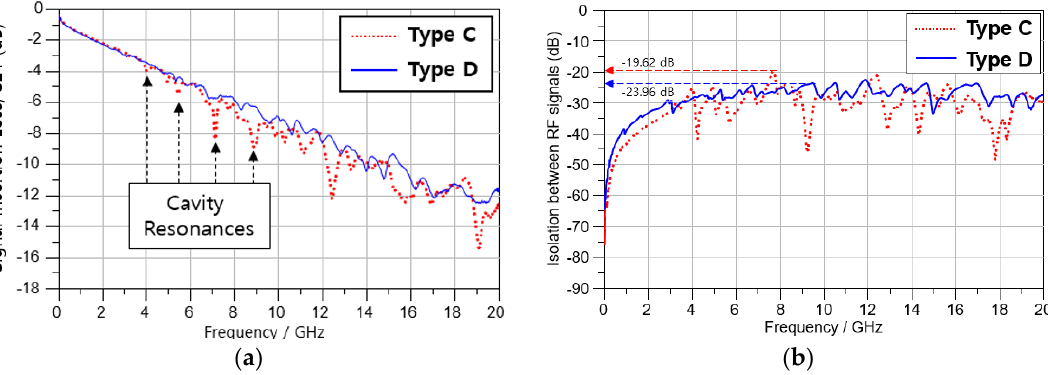
Figure 13. Measurement results of Type C and Type D whose length of RF signal traces is 158 mm. ( a ) Signal insertion loss and ( b ) Isolation between RF signals.